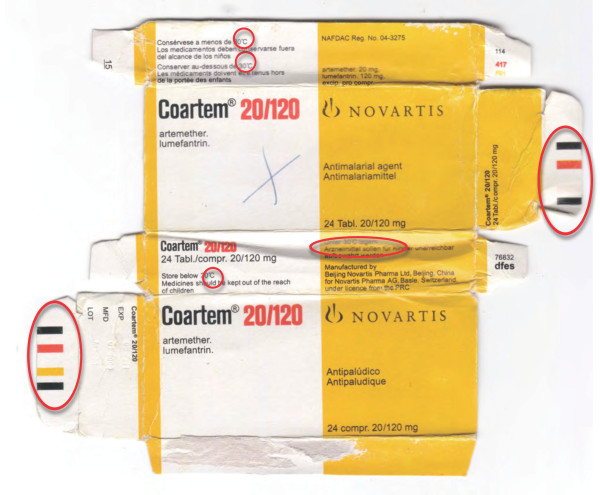
Counterfeit 'Coartem' labelled as made by 'Beijing Novartis Pharma Ltd, Beijing, China for Novartis Pharma AG, Basle, Switzerland' (Gh 09/01). Differences from genuine sample (Figure 16) in red circles.